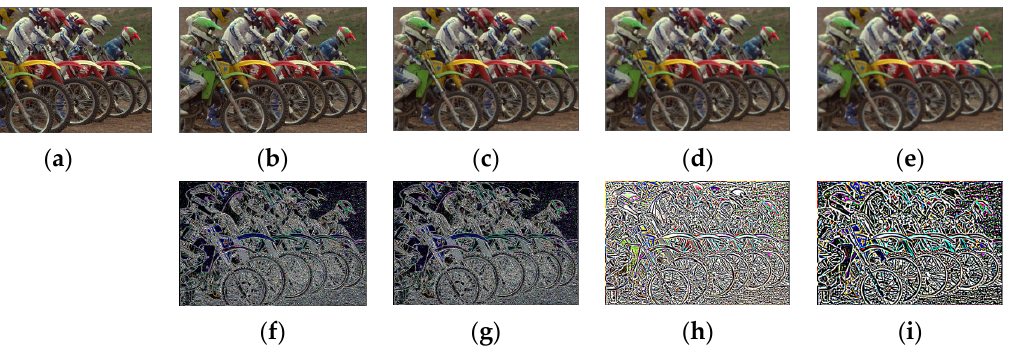
Figure 4. Examples of scale space and contour features of a image in the LIVE database. ( a )–( e ) are an image scale space of ( a ). ( f )–( i ) are contour features of different scales of ( a ).